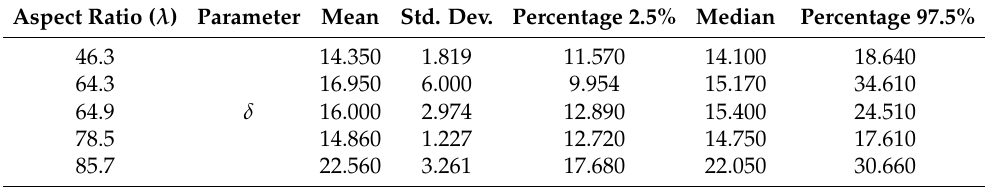
Table 3. Statistics of the parameter δ obtained for different aspect ratio